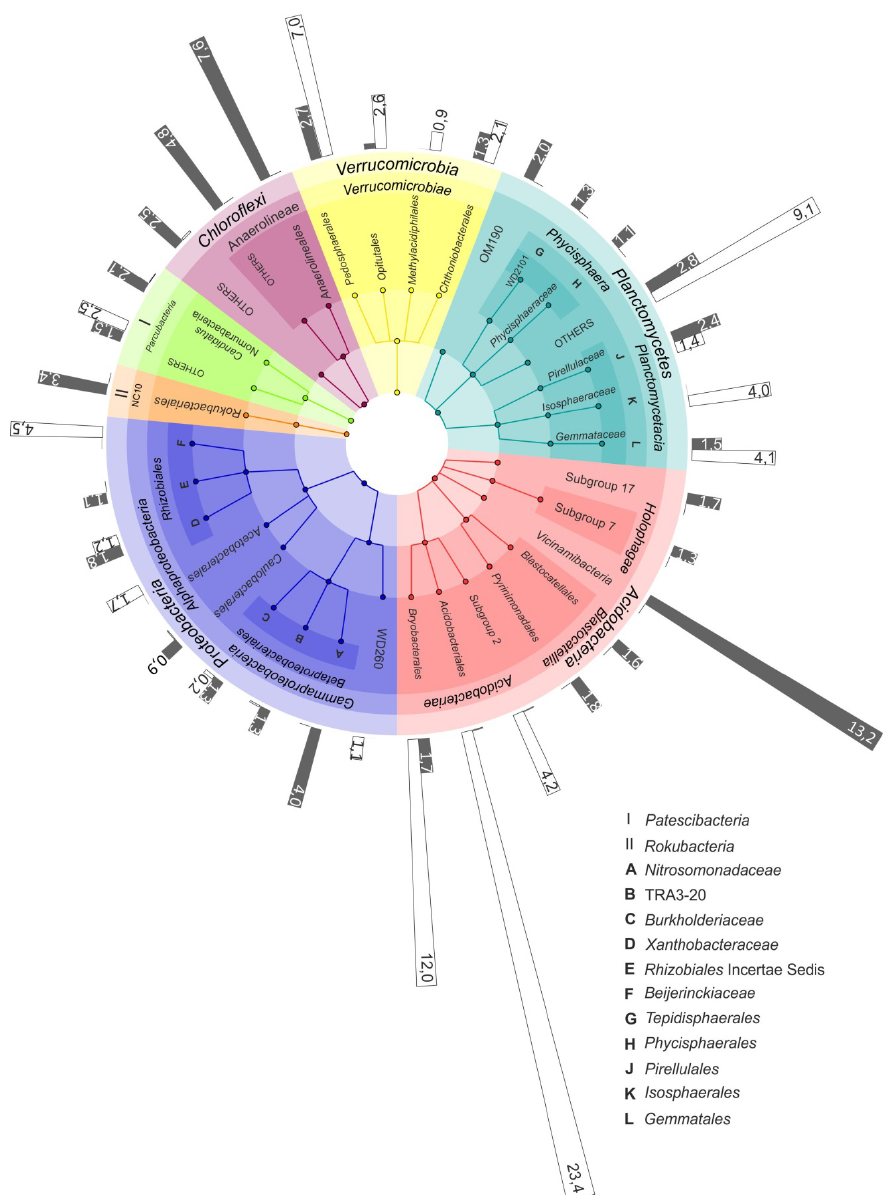
Figure 4. The most representative microbial groups in the bog and fen sites of the Shichengskoe mire. The outermost circle shows the relative abundance of specific microbial group in the raised bog (white bars) and in the fen (grey bars). The colored nodes from inner ring to outer ring indicate taxonomic groups from phylum to family level.